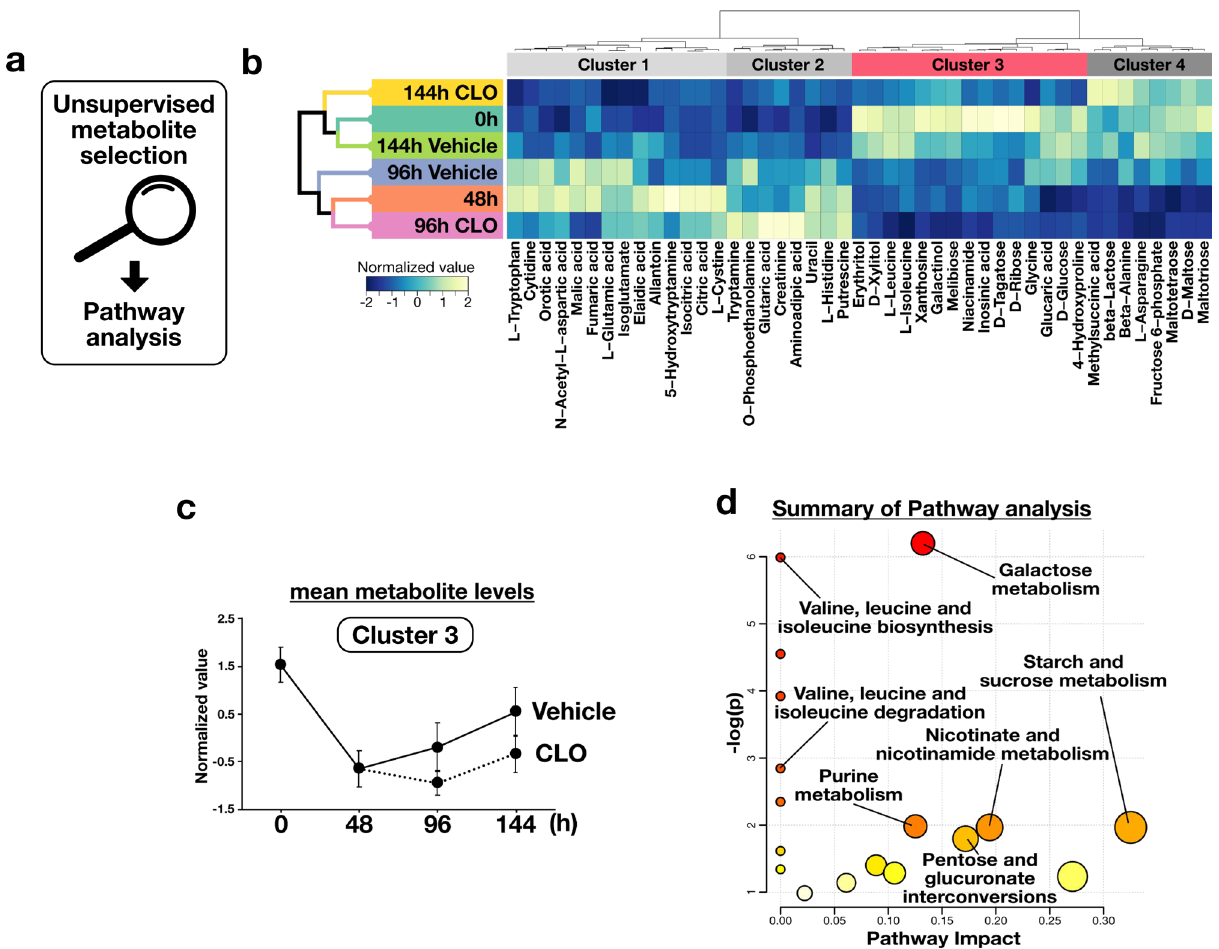
Figure 4. Characterisation of the liver metabolome during regeneration after acute liver injury. ( a ) Characterisation of the liver metabolome by GC/MS. Bioinformatic data were collected, and multivariate analyses were performed by using R software. ( b ) Heatmap of selected metabolites. The coloured blocks indicate group mean levels. Hierarchical clustering was performed using the correlation-based distance and the ward. D2 clustering method. ( c ) Group mean levels of metabolites classified in Cluster 3. ( d ) The results of pathway analysis performed using Metaboanalyst 4.0. The group mean levels are presented as mean ± standard deviation (SD; 15 metabolites in each